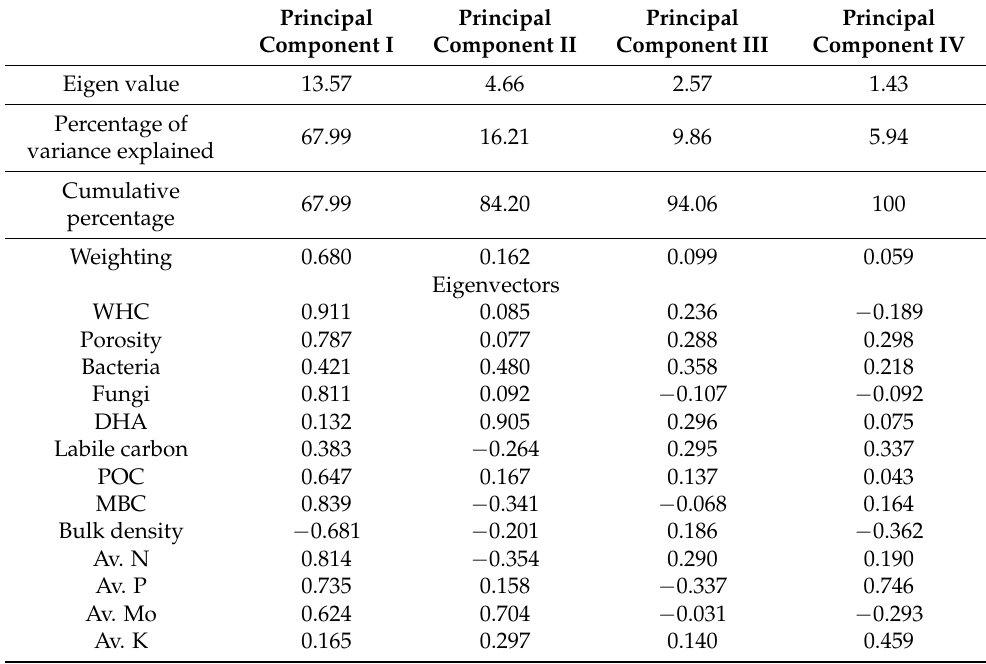
Table 3. Factor loading/Eigenvectors of significant soil quality indicators from PCA.